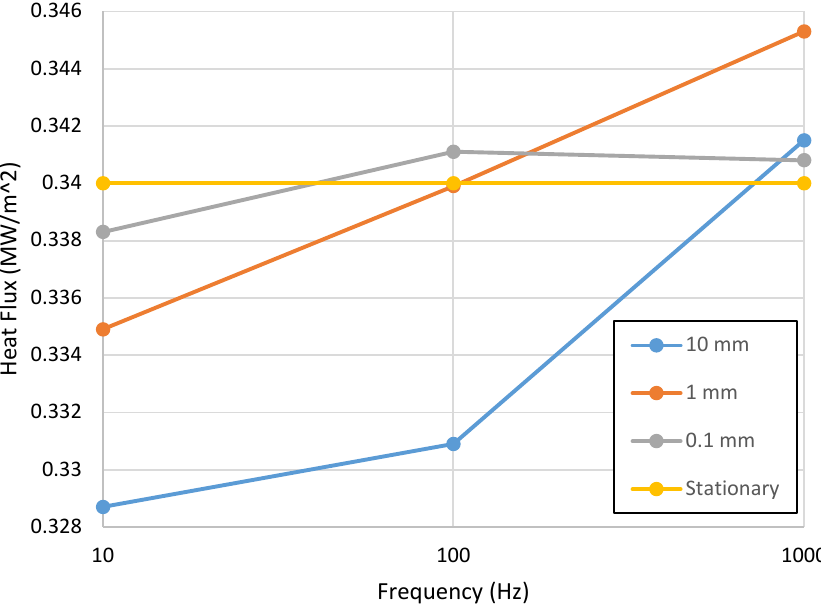
Figure17. Figure 17. Time-averaged heat flux for single-droplet impingement onto stationary and moving boundaries.